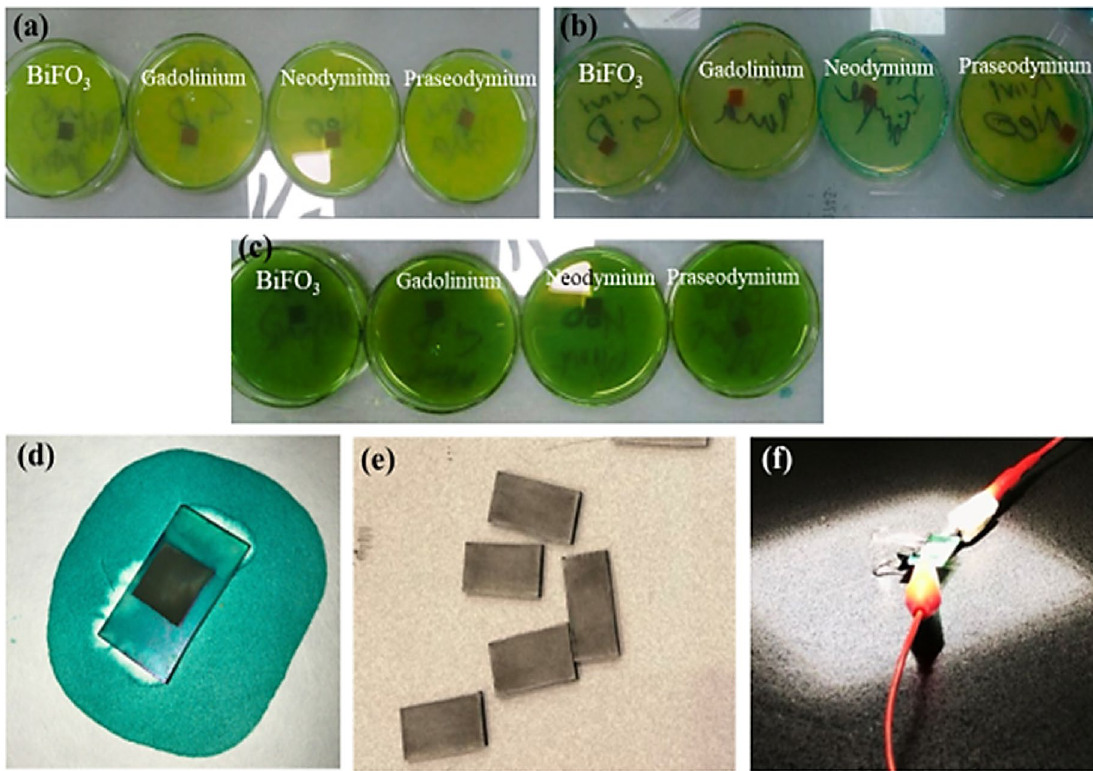
Figure 5. Method of assembling of the cell: ( a ) Photoanodes immersed in mint dye ( Mentha ), ( b ) Photoanodes immersed in Kiwi dye ( Actinidia deliciosa ), ( c ) Photoanodes immersed in the synthetic malachite green dye, ( d ) Photoanode taken out from the dye, ( e ) Carbon coated FTOs, and ( f ) Assembly of a